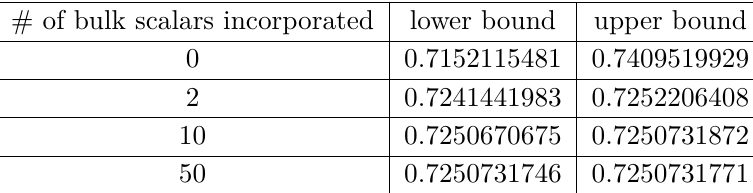
Table 7. Upper and lower bounds on the g function for stable boundary conditions in the ( G 2 ) 1 WZW model at N = 127 derivative order with an increasing number of low-lying bulk scalars incorporated. The bounds appear to be convergent upon